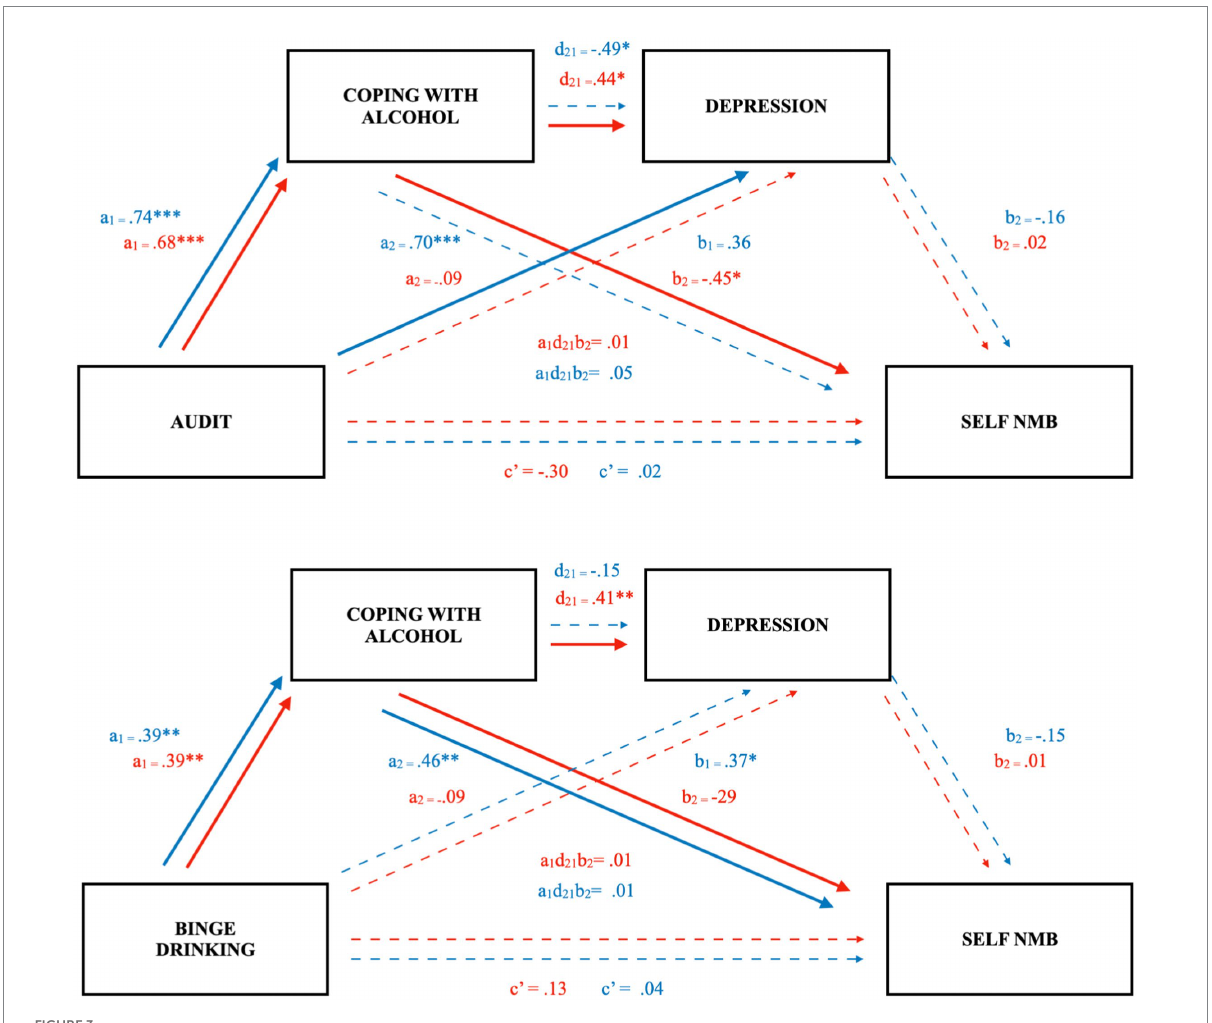
FIGURE 3 Coping mediates the relation between problematic drinking and a self-referent negative emotional memory bias in community females but not males (Study 3). Figure depicts separate serial mediation models with females in red, males in blue. Solid lines and bolded parameters reflect significant relations: * p < 0.05, ** p < 0.01, *** p <